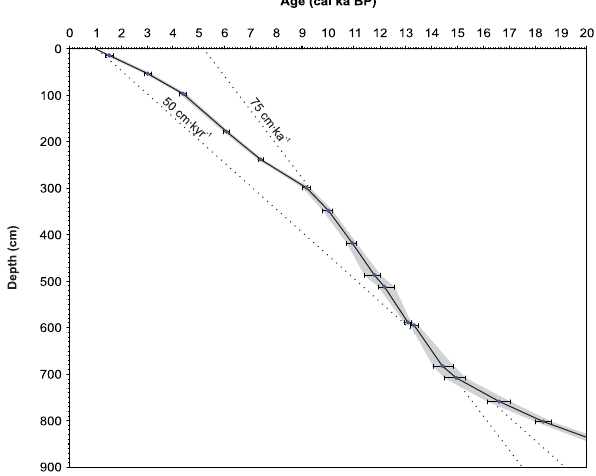
Fig. 3. Age-depth profile for core MD95-2043 (last 20ka) based on calibrated AMS radiocarbon data from Cacho et al. (1999) shown in Table 1, showing the central age estimate and 2 σ uncertainty intervals. The shaded band shows the 2 σ uncertainty